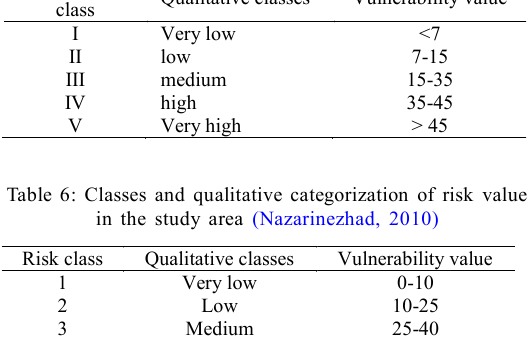
Table 5: Class and vulnerability value of elements at risk (Arami, 2012) information systems. Table 7 details the standard maps